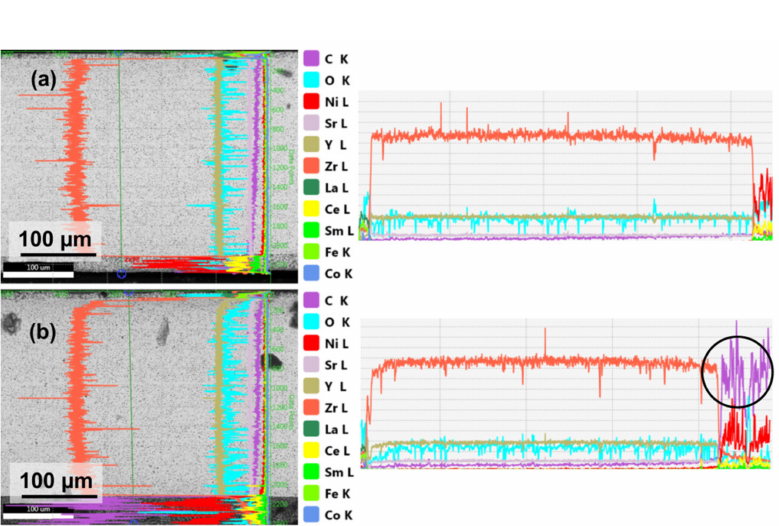
Figure 12. FESEM and EDX analyses in line-scan mode at the cross-section of the single cell based on on NS-GNP: ( a ) hydrogen and ( b )